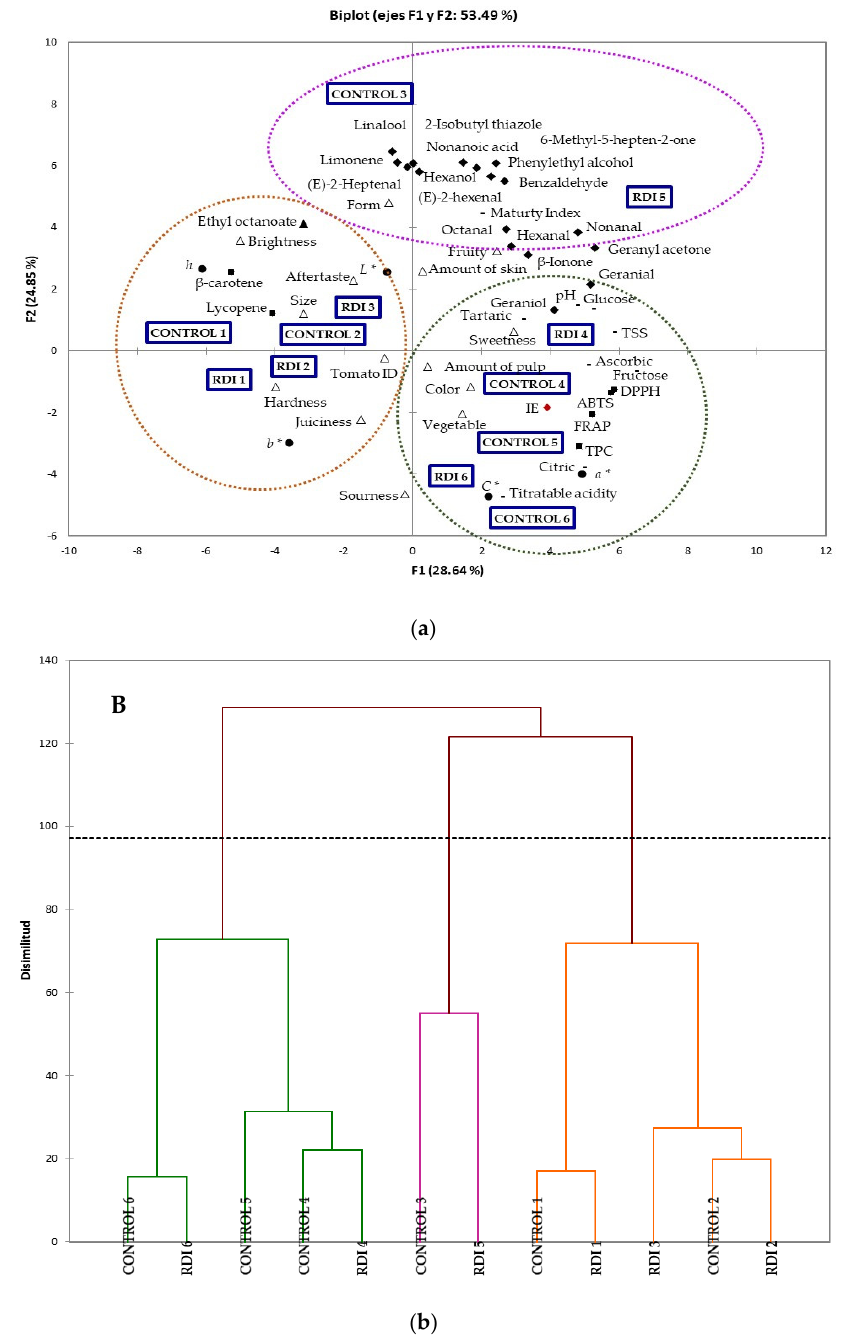
Figure 5. ( a ) PCA and ( b ) cluster maps prepared using, ( ) Stress Integral, ( ● ) color, ( − ) TSS, pH, titratable acidity, maturity index, organic acids, and sugars, ( ) antioxidant activity, lycopene¸ β - Carotene and total polyphenol content, ( Δ ) sensory profile, and ( ) volatile compounds in cherry tomato samples.